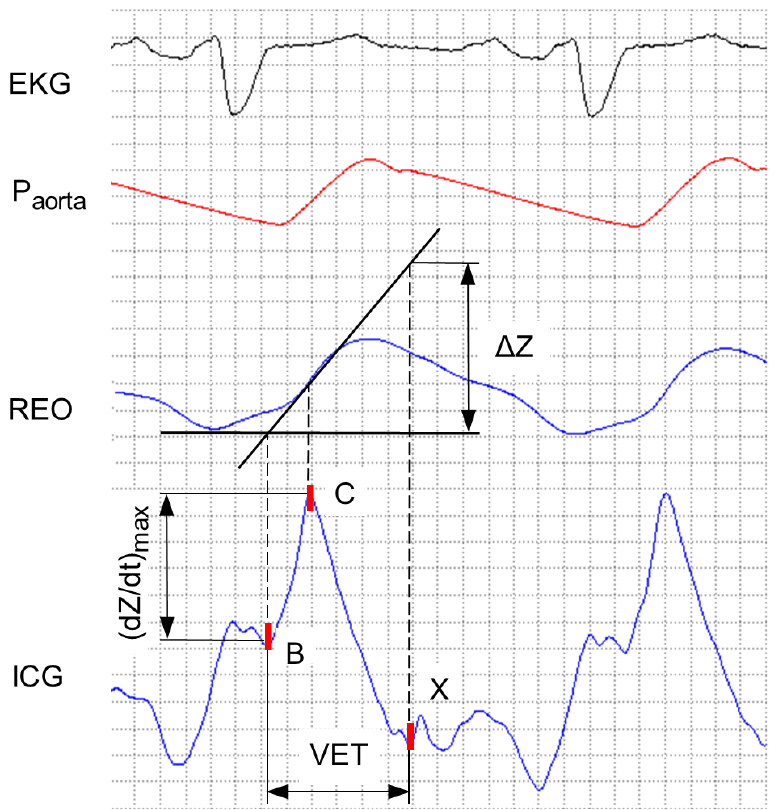
Figure 1. The simultaneously recorded ECG, aortic pressure P aorta , REO (bioimpedance Z ), and ICG signals dZ signals. The line on the REO signal illustrates the way to determine the real value of the dt impedance variation ∆ Z with a slope extrapolation. The corresponding fragment of the maximum ) max found with this method is also depicted in the ICG signal. increase of the bioimpedance ( dZ dt Points B, C, and X indicate the characteristic moments of the cardiac cycle and are explained in more detail in Table 1. The quantity VET illustrates the ventricular ejection time defined as the distance between X and B